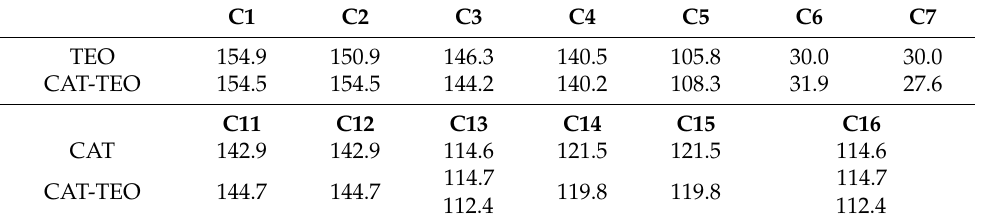
Table 3. Calculated (δcalc) and experimental (δexp) CP/MAS solid state 13 C NMR chemical shifts (ppm) of TEO and CAT in the 1:1 anhydrous ground mixture, and calculated (root mean square error less than 4.0) GIAO isotropic magnetic shielding tensors (σiso).